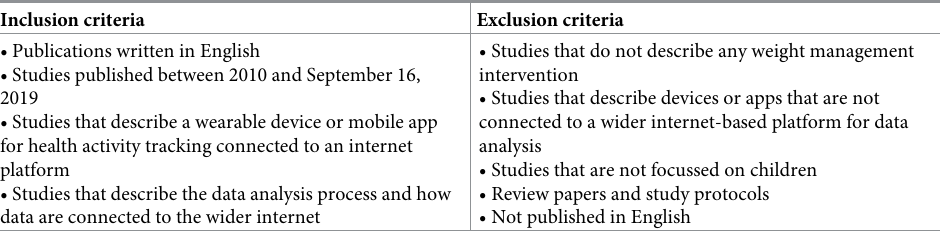
Table 6. Study inclusion and exclusion